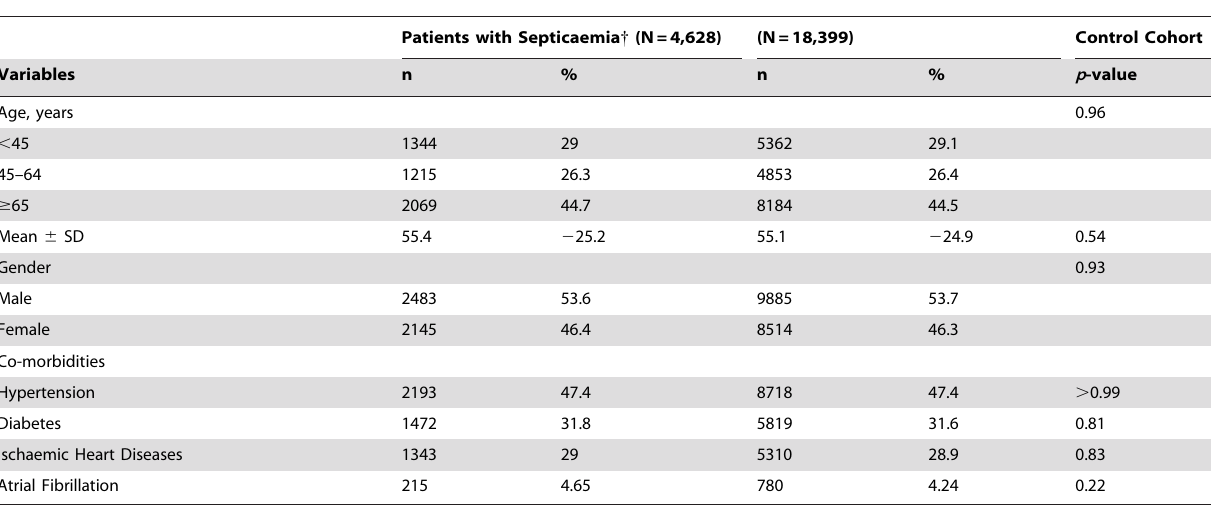
Table 1. Baseline characteristics of the septicaemia group and the control cohort.